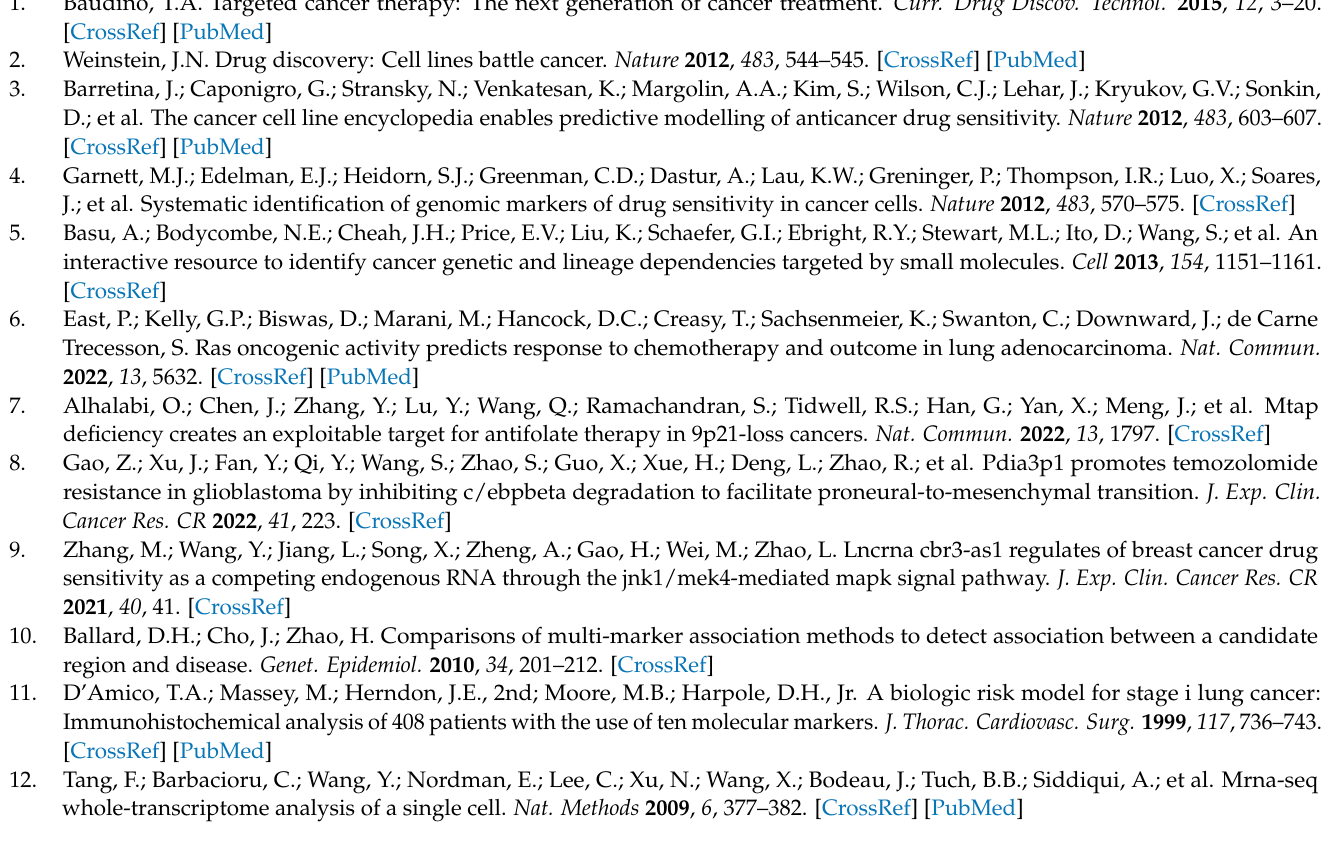
cell lines. The blue dots represent drug-sensitive cell lines. (B) The distribution of drug according to p -values of one-sided Wilcoxon tests (calculated by differential DRS analysis between resistant and sensitive cell lines). The x -axis represents the p -value, and the y -axis represents the number of drugs. Figure S6. Comparison of accuracy between scDR and Beyondcell. The x -axis represents the FDA-approved drugs. The y -axis represents the weighted probabilistic c-index (WPCI). Figure S7. (A) Box plot of DRS s for d0-S and d0-R cells. (B) Pseudotime cell trajectories colored by cell clusters. Figure S8. Kaplan–Meier curves for SKCM patients according to mean values of gene expression. Resistance-related genes significantly related to survival are shown. Figure S9. Enrichment map of Gene Ontology (GO) for the upregulated genes in cluster d0-R. The node size represents the number of genes in a GO term. The edge width represents the similarities between GO terms. Figure S10. Box plot of DRSs for SUM159DMSO (sensitive cells) and SUM159RDMSO (resistant cells) cell